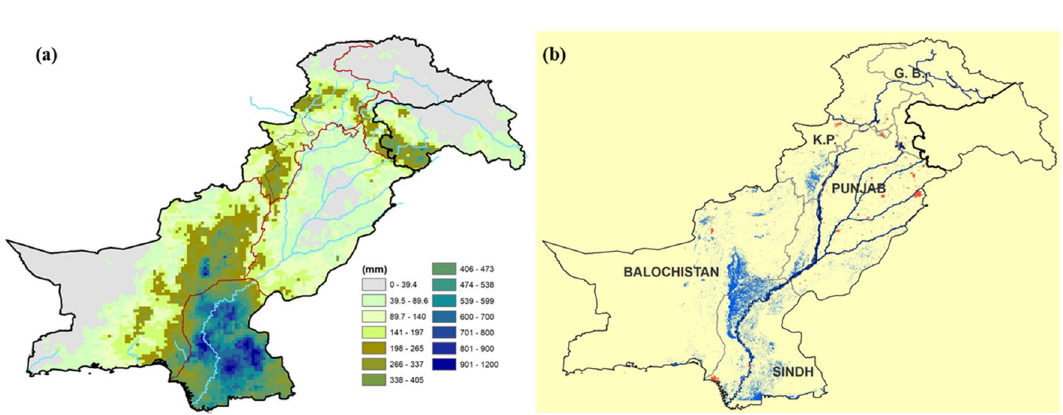
Figure 4. ( a ) Rainfall estimates for August 2022 in Pakistan (Source: GPM -IMERG satellite data), ( b ) Fig. 1: Flood extent in Pakistan on 28 August 2022 based on Sentinel-satellite data (Source: Sentinel-1 satellite data, the maps were produced using the ArcGIS 10.7 (www. esri. com).